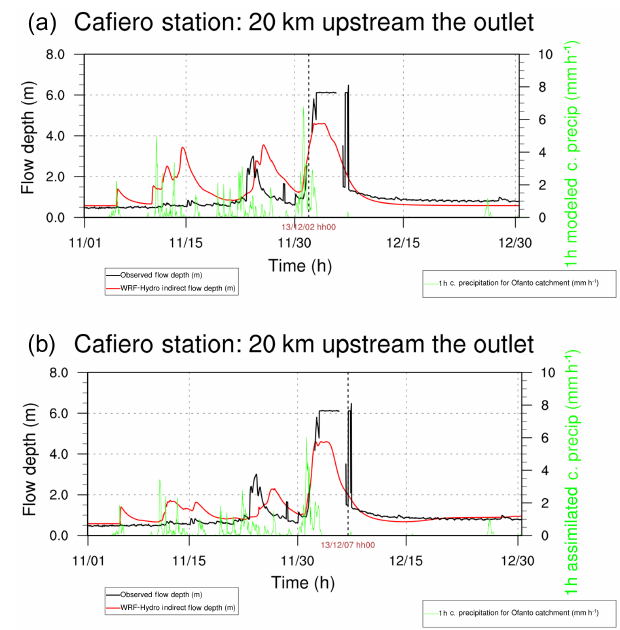
Figure 10. Validation of the Ofanto discharge for Experiment 2 at Cafiero station. (a) Modelled precipitation. (b) Assimilated precip- itation. The gaps in the black line are due to the river flood which damaged the gauge